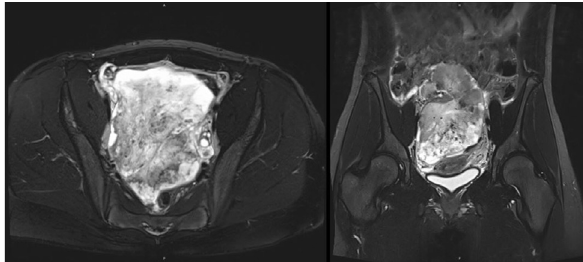
Fig. 1 Preoperative MRI scan (T2-weighted sequence) revealed a large pelvic mass of unknown origin. MRI, magnetic resonance imaging.